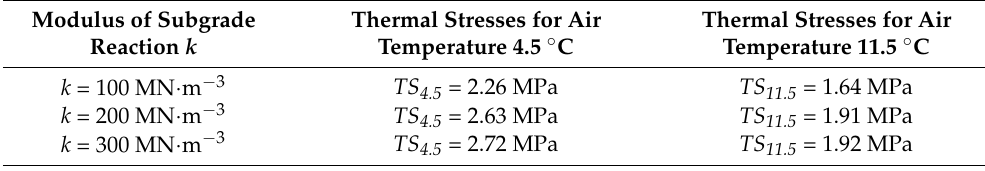
Numerical Results—Surface Normal and Shear